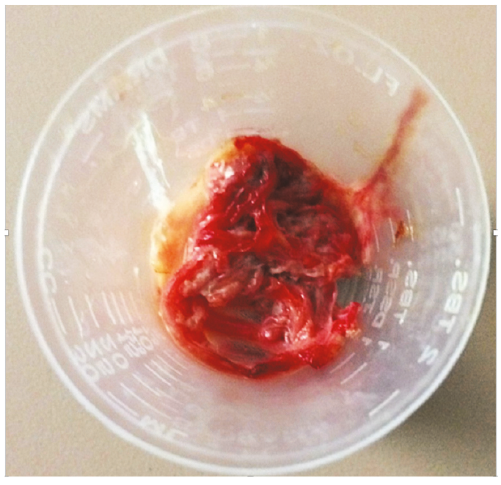
Figure 1: The rubbery red and white material expectorated by the